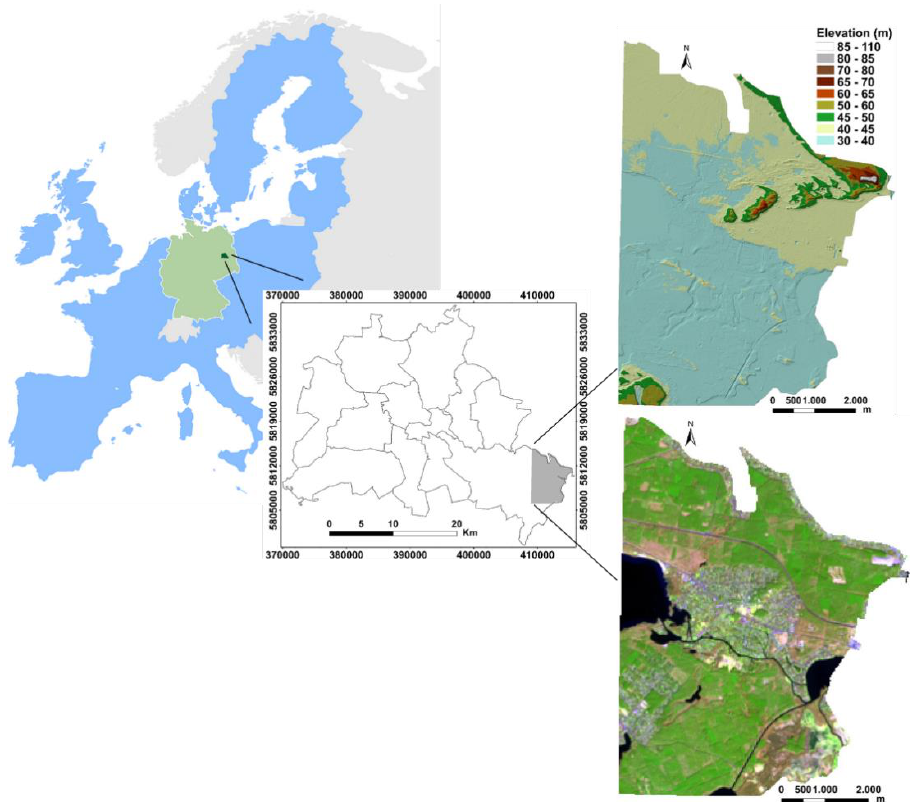
Figure 1. Location of the study area in the city area of Berlin, analytical light detection and ranging (LiDAR)-digital elevation models (DEM, upper ) and false colors composite of Landsat 8 Operational Land Imager (OLI) image of 2018 (band 6-5-4 as red, green, and blue (RGB) color) ( below